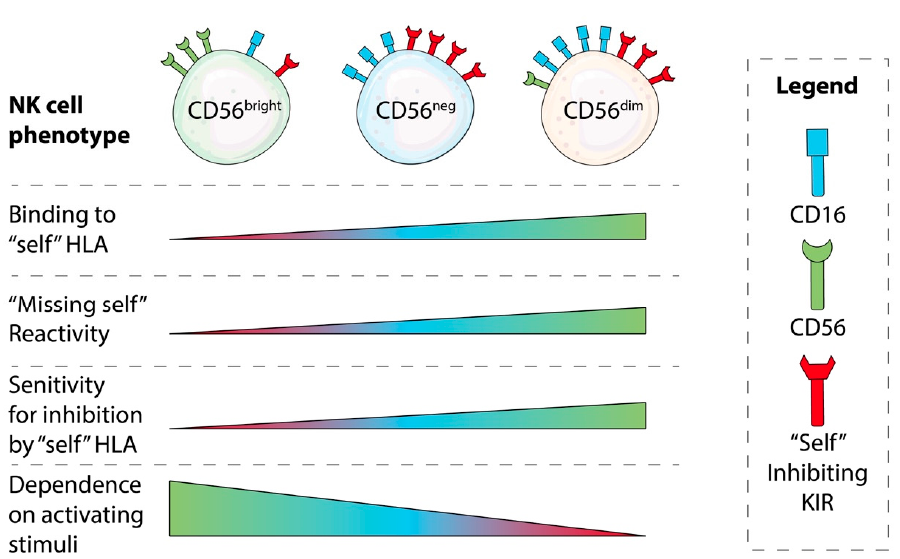
Figure 1. NK cell phenotypic variation and its impacts on NK cell education and interactions with viruses. NK cells are educated based on the interaction between their receptors and “self” HLA class I molecules. KIR, a family of receptors on NK cells that can be categorized as inhibitory or activating, bind to “self” HLA molecules. Highly educated NK cells are those whose inhibitory KIR strongly engage “self” HLA. This permits strong missing self reactivity, but also renders educated cells sensitive to inhibition against targets where HLA expression persists. By contrast, poorly or uneducated NK cells require strong activating signals to become reactive, but remain refractory to inhibition by HLA molecules. Hence, NK cell education creates a spectrum of diversity in NK cell effector responses. Some chronic viral infections, such as HCV, can skew an individual’s NK cell repertoire toward one comprised of cells with the phenotypic and functional characteristics of a naive population, including poorer cytotoxicity. During chronic infection, CD56bright NK cell populations diminish while CD56dim and CD56neg NK cell populations expand. The resulting NK cell populations display more CD16 receptors (which are responsible for ADCC), and increased activating receptor density, but are inefficient for eliminating infection. Depending on the virus and host HLA, infected target cells may persist in HLA expression, induce its downregulation, or modify HLA with KIR-antagonizing peptides [24]. Hence, diversity in education and HLA binding sensitivity could have important impacts on the ability of NK cells to